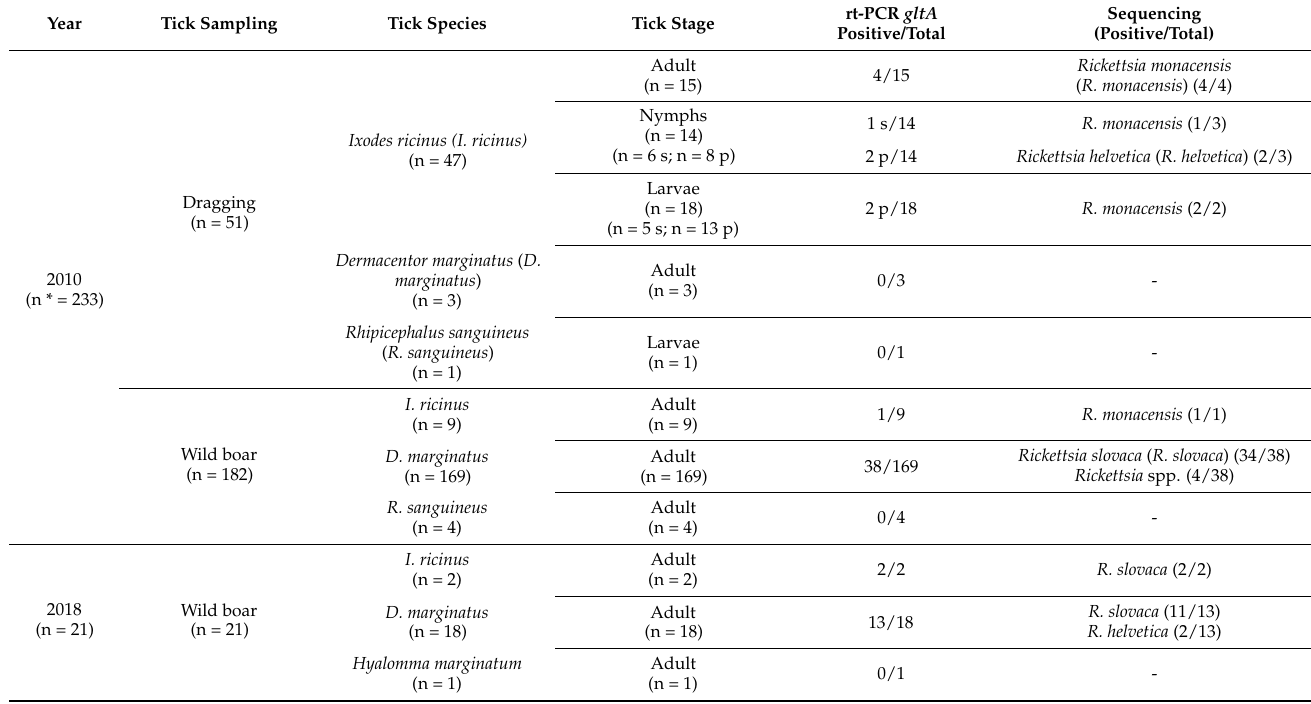
Table 1. Tick sampling data with respect to year and method of sampling, tick species and stage and the results of the real-time PCR screening and Rickettsia species